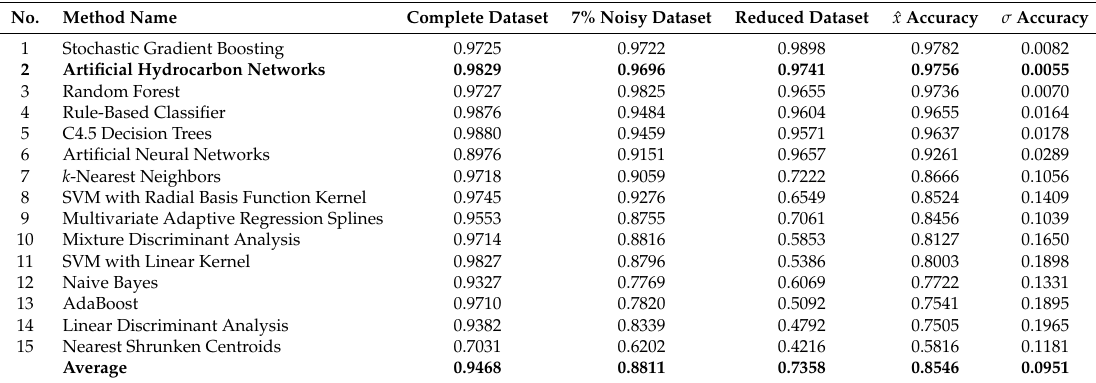
Table 18. Overall performance of supervised classifiers during the experiments with respect to the ˆ x accuracy metric.